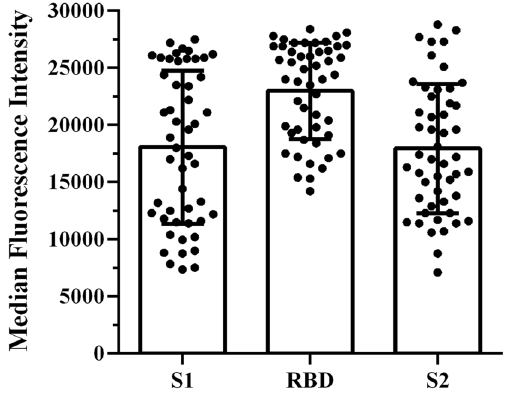
Figure 2. Viral protein-specific serum antibody levels in response to SARS-CoV-2 mRNA vaccination. Spike protein subunit 1 (S1), receptor binding domain protein (RBD), and spike protein subunit 2 (S2) ( N =